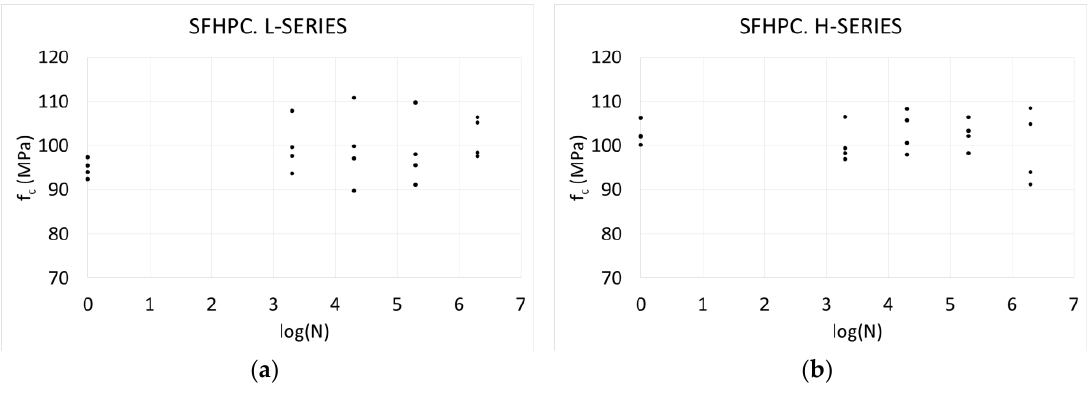
Figure 4. Variation of compressive strength by number of cycles. HPC ( a ) L-Series. Raw values. ( b ) H-Series. Raw values. ( c ) L-Series. Maximum, minimum, and average relative values, and tendency lines. ( d ) H-Series. Maximum, minimum, and average relative values, and tendency lines.